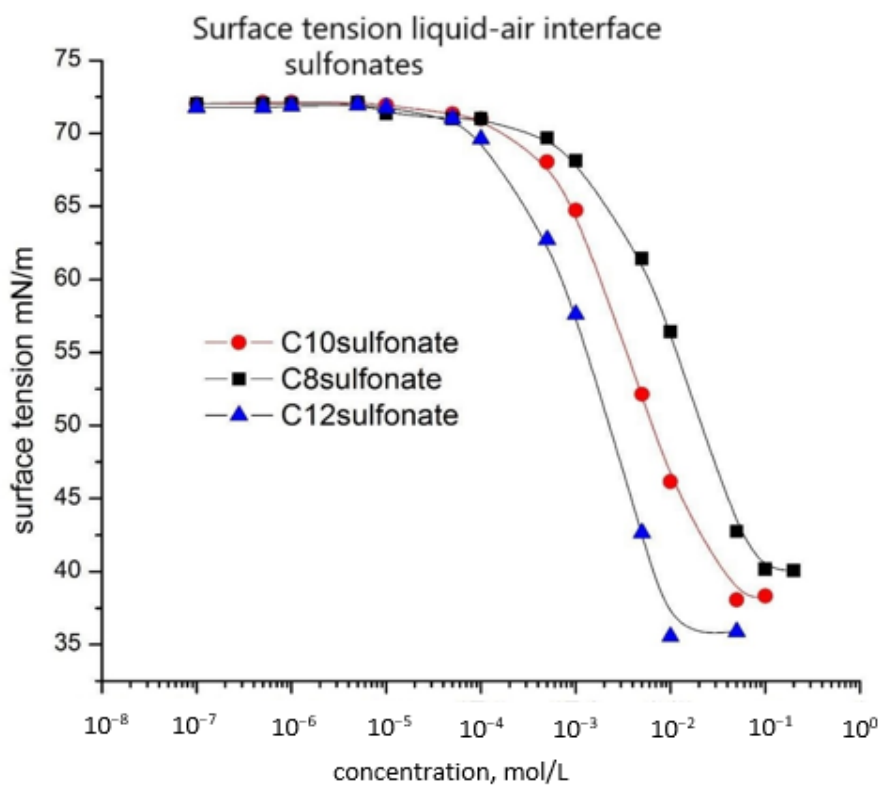
Figure 2. Measured surface tension versus surfactant concentration for different sulfonates [55] . Reprinted from Ref. [55] with permission. Copyright Elsevier 2009.